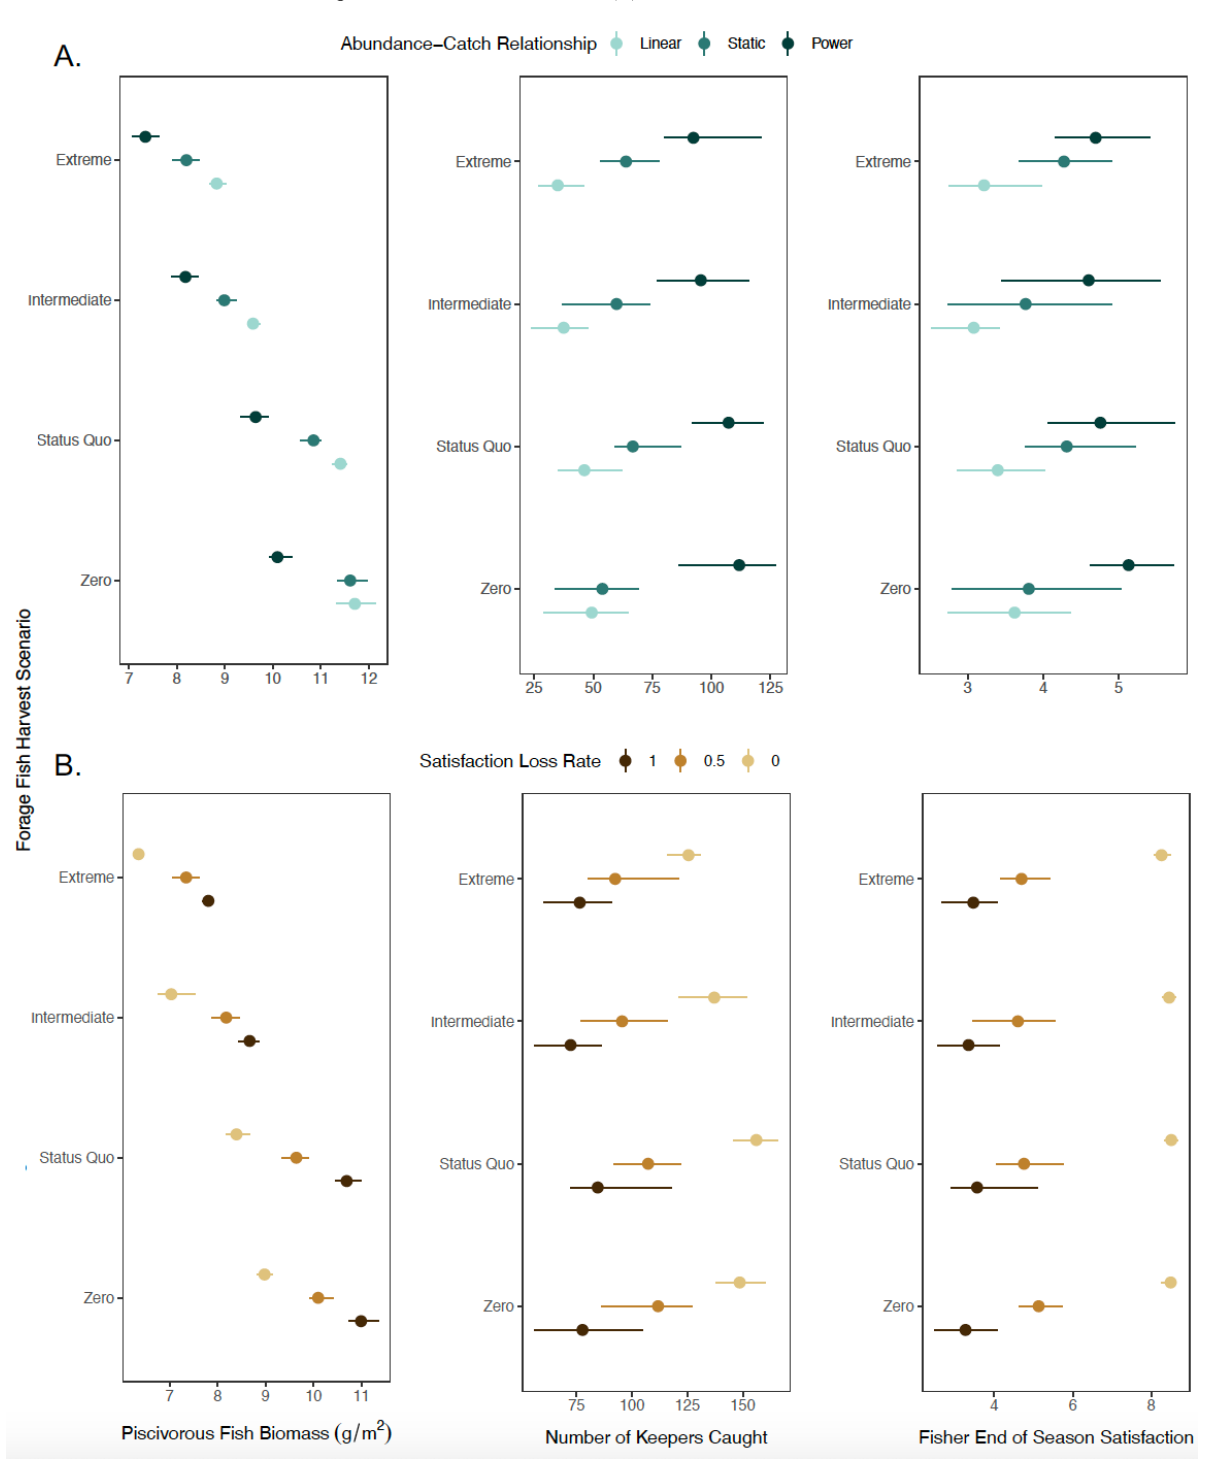
Fig. 5 . The mean and data spread (of each 8-year trial) of piscivorous fish biomass, the number of keepers caught, and fisher end of season satisfaction for the four harvest scenarios. Color indicates the type of fisher behavior model trial, where the top row (A) shows the abundance-catch relationship trials, and the bottom row (B) shows the satisfaction loss rate